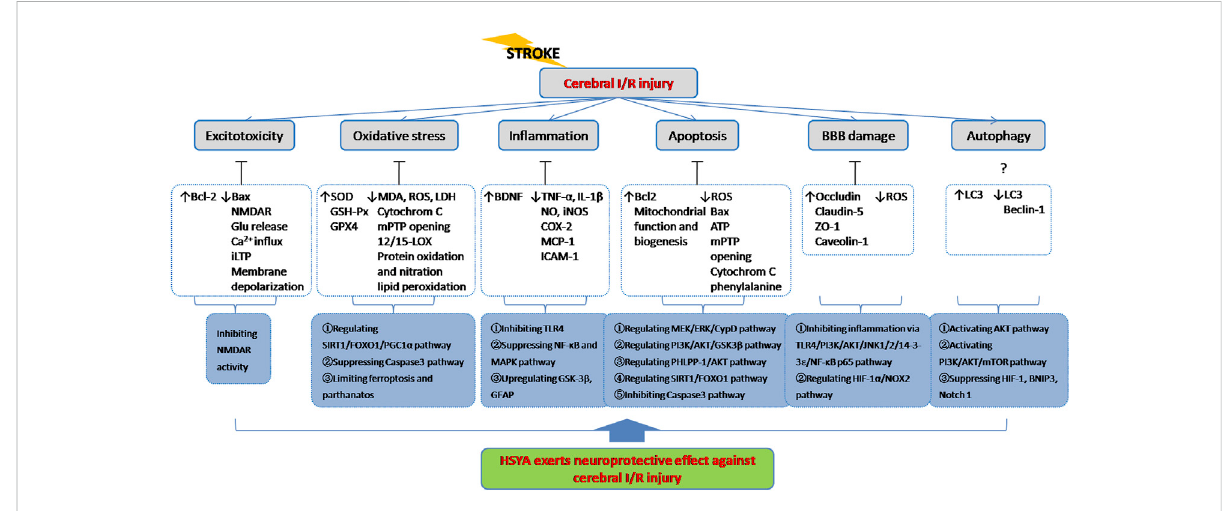
FIGURE 4 HSYA acts on the functional targets and signaling pathways of cerebral I/R injury. Indicator: ↑ , upgrade; ↓ , downgrade; ?,